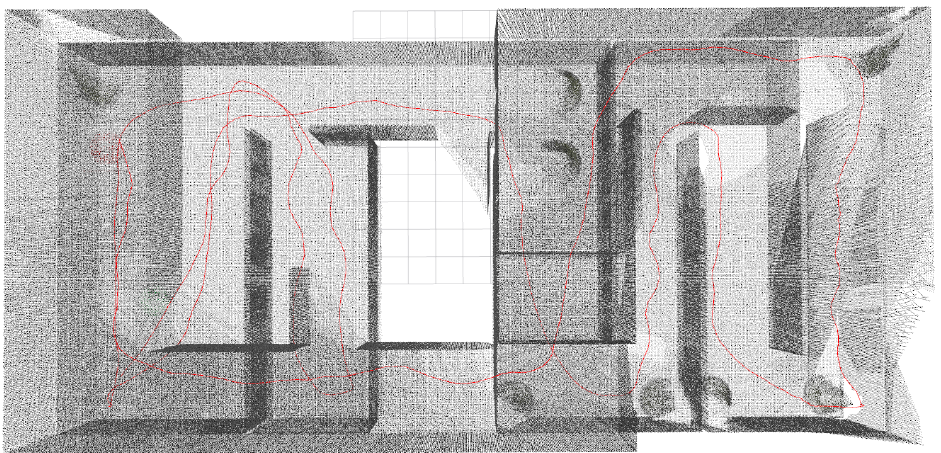
Figure 31. This figure illustrates the trajectory of the UAV from the starting location to the target location in the unknown environment (top